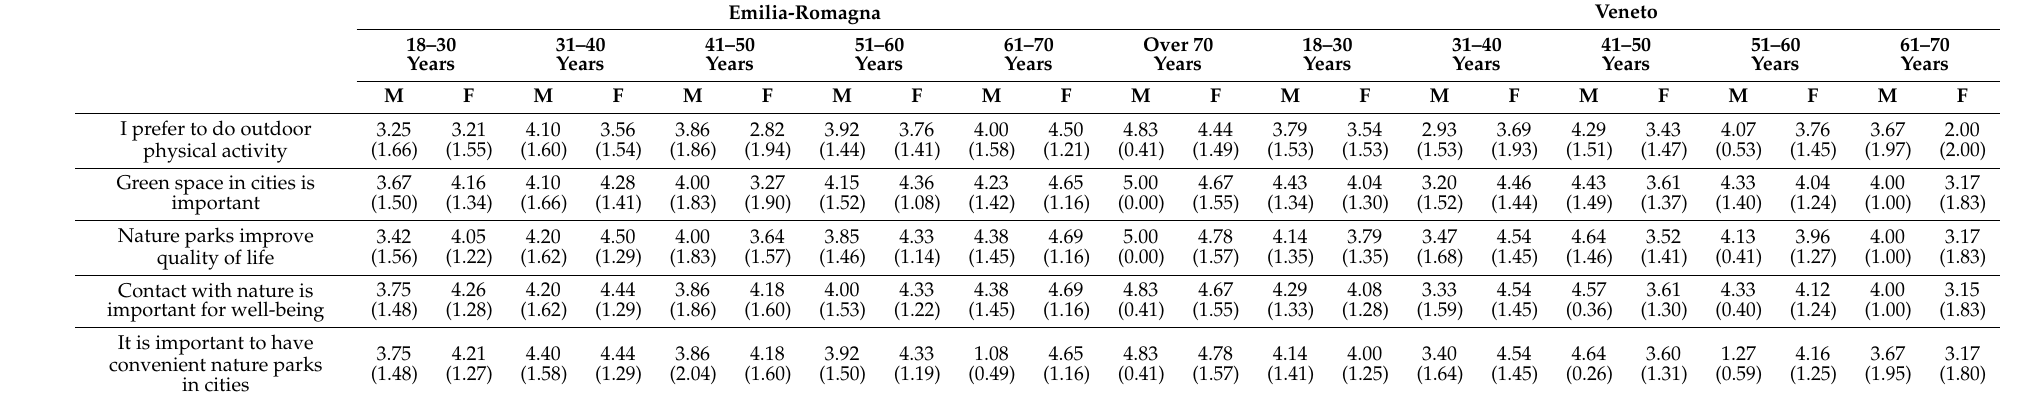
Table 4. Descriptive statistics in Emilia-Romagna and Veneto for age groups and